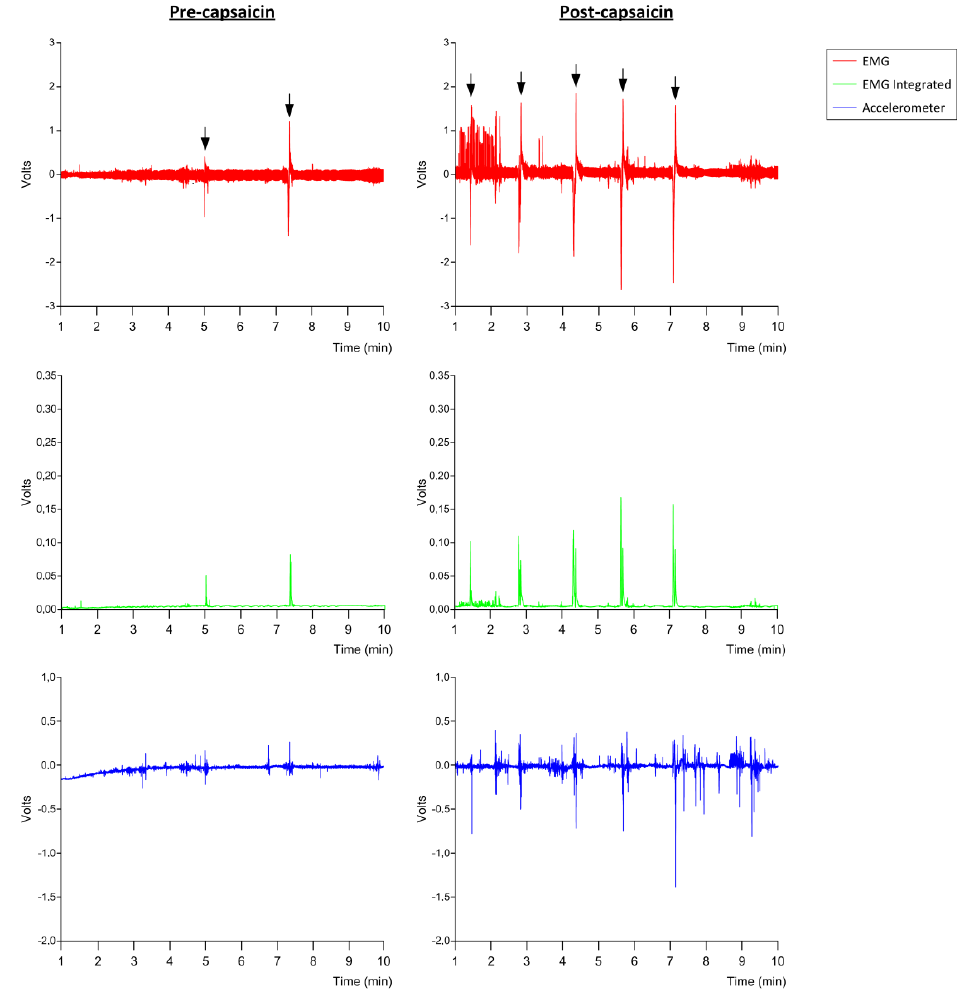
Figure 7. Pre- and post-capsaicin stimulation SSF registration. Red line represents the electromyo- graphy (EMG) signal; green line represents the EMG integrated signal; blue line represents the accelerometer movement; black arrows point to each swallow